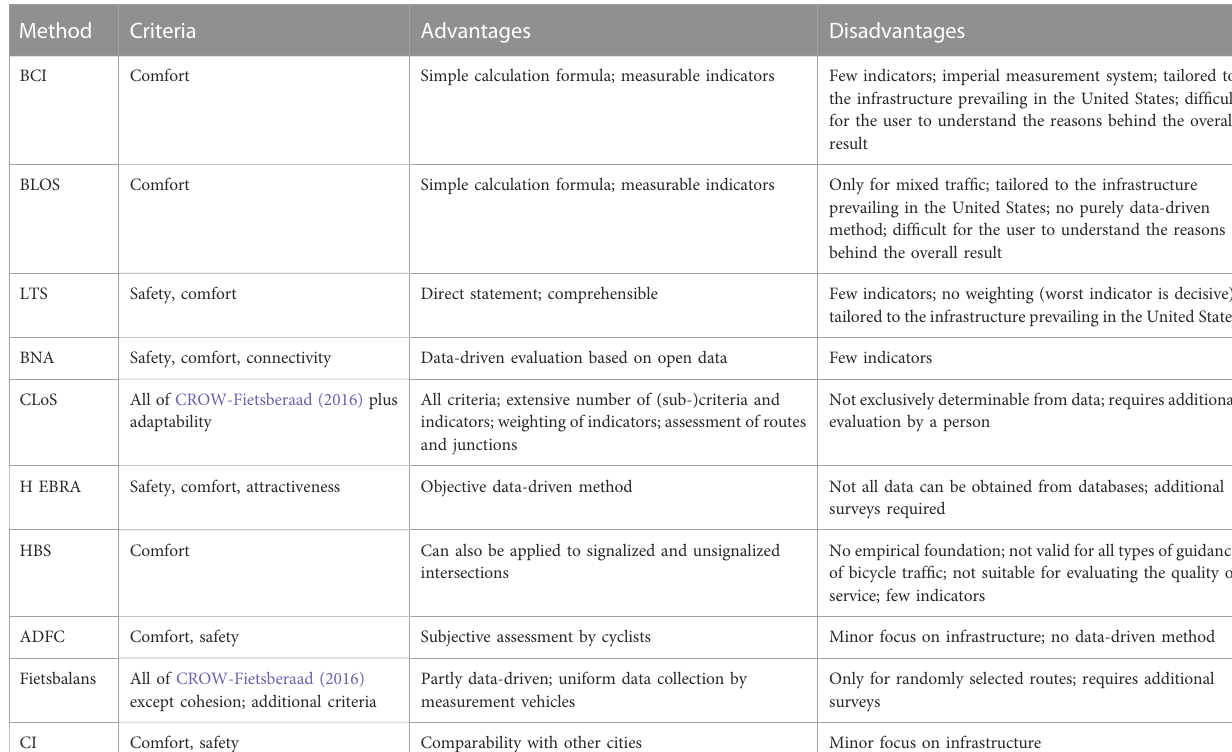
TABLE 1 Summary of quality assessment methods for cycling